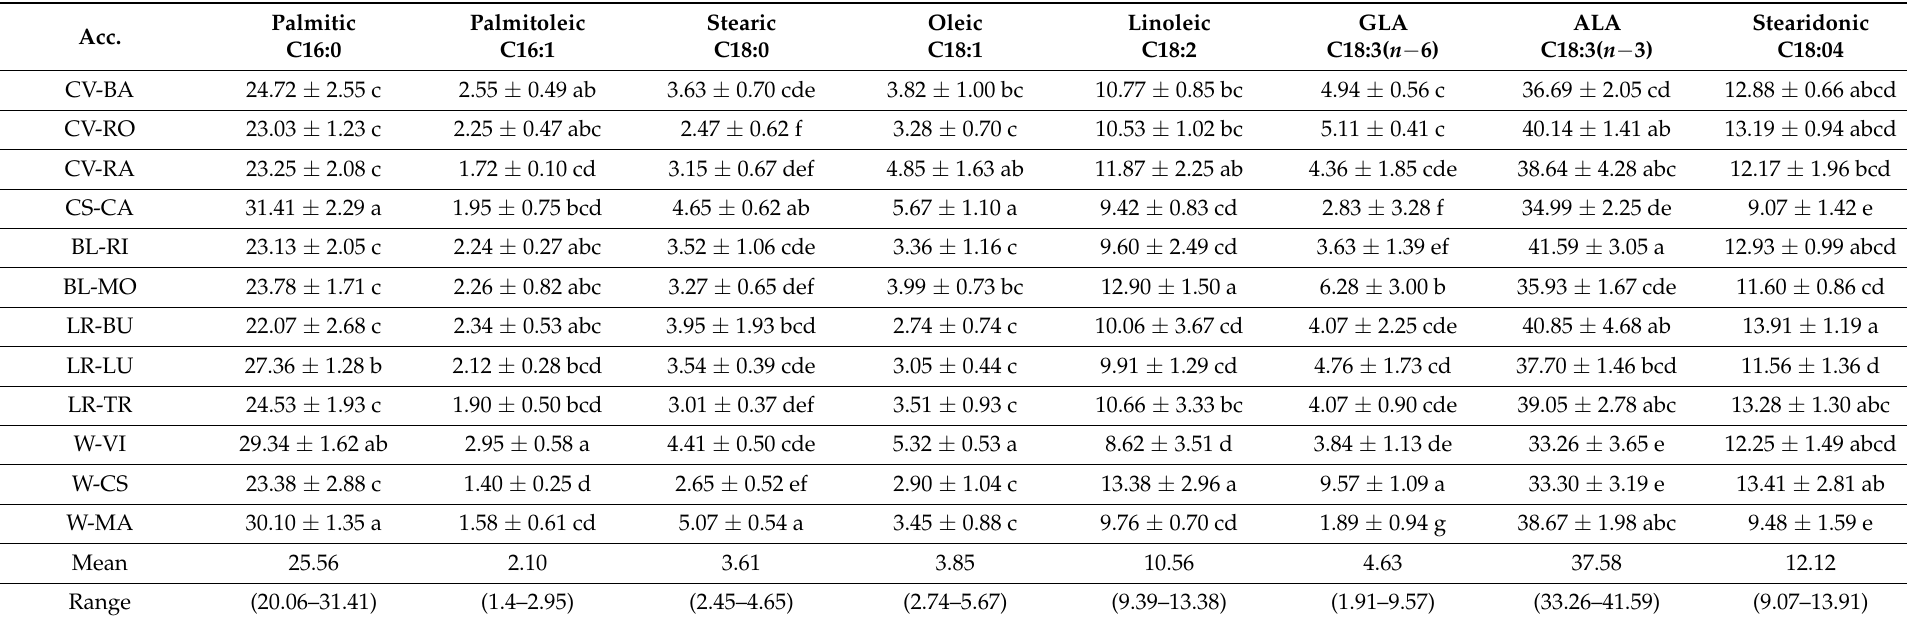
Table 5. Fatty acid composition, expressed in percentage of total fatty acids, of leaf blades of 12 borage accessions sampled at 150 days after sowing (Mean ± SD (n =